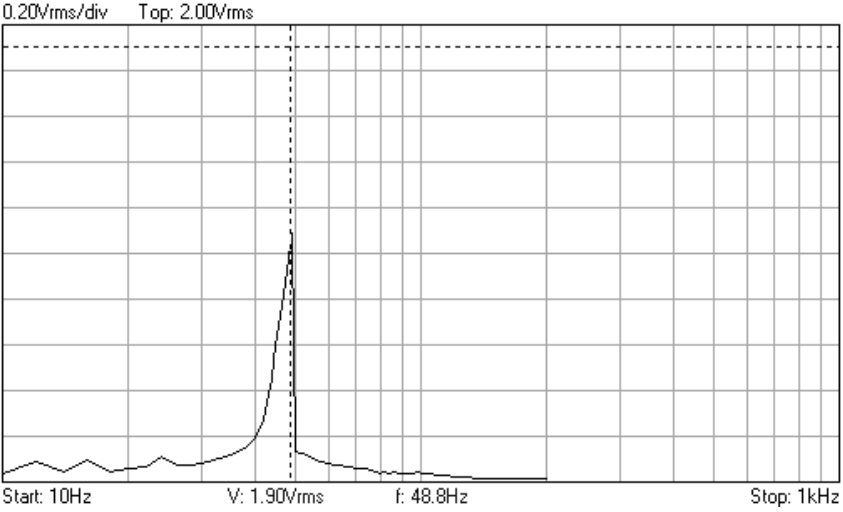
Figure 16. Frequency spectrum with the mass of 0.620 kg recorded after 141,000 cycles at 94 Hz. The frequency of the stress cycles was maintained at the value of 63.5 Hz for just